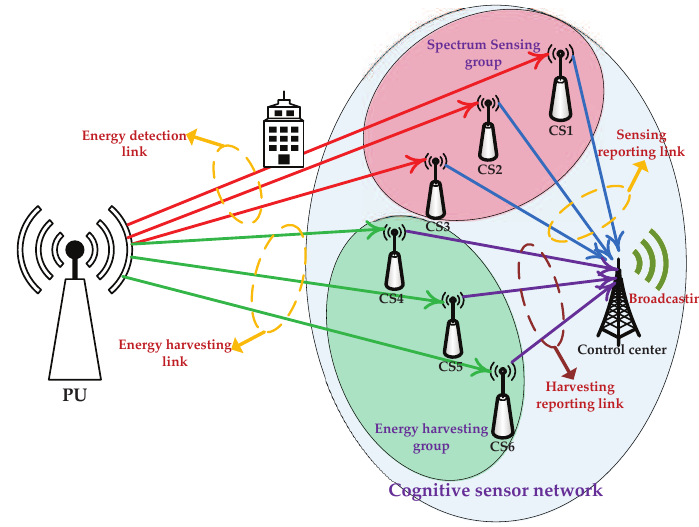
Figure 5. Cooperative cognitive sensor network structure.